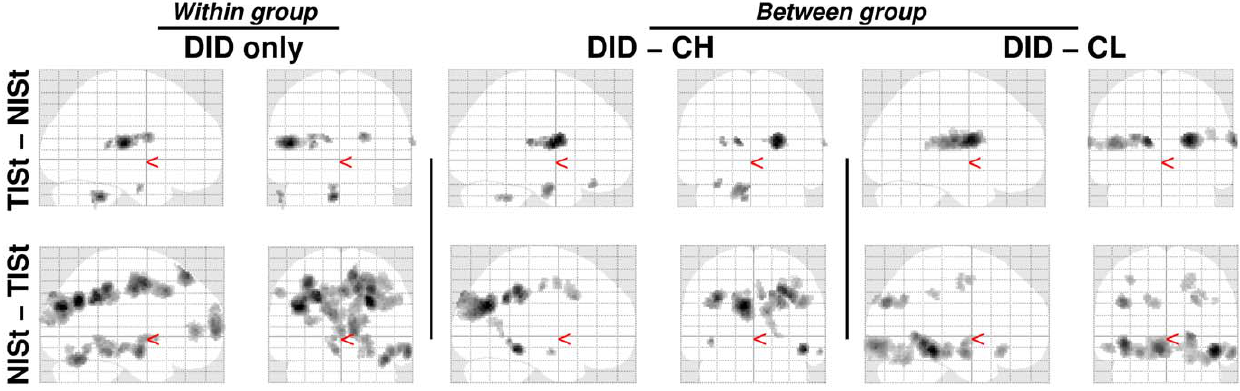
Figure 5. ‘‘Glass brain’’ renderings show differences in the processing of the trauma-related text (indicated with a small ‘t’) between the trauma-related identity state (TIS) and the neutral identity state (NIS). Differences in regional cerebral bloodflow patterns for the dissociative identity disorder (DID) group (left) and the comparison of this group to the high (middle) and low (right) fantasy prone DID simulating controls (CH and CL respectively) are depicted. See Table 4 for the specific